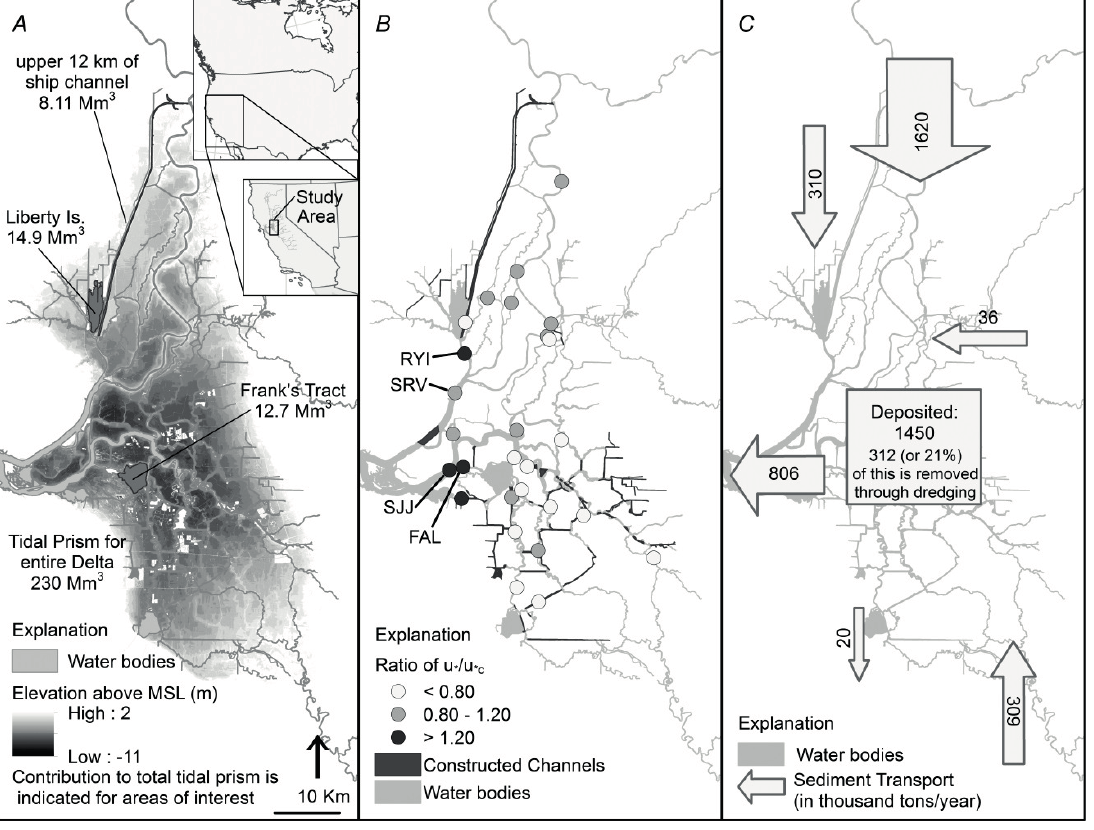
Fig. 3 Maps showing: tidal prism of areas of interest, total tidal prism of Delta and elevation of adjacent land above/below mean sea level (MSL), in metres (A); ratio of average shear velocity to critical shear velocity at each site, constructed water channels are also indicated (B); average annual sediment transport to and from the Delta 1997–2010